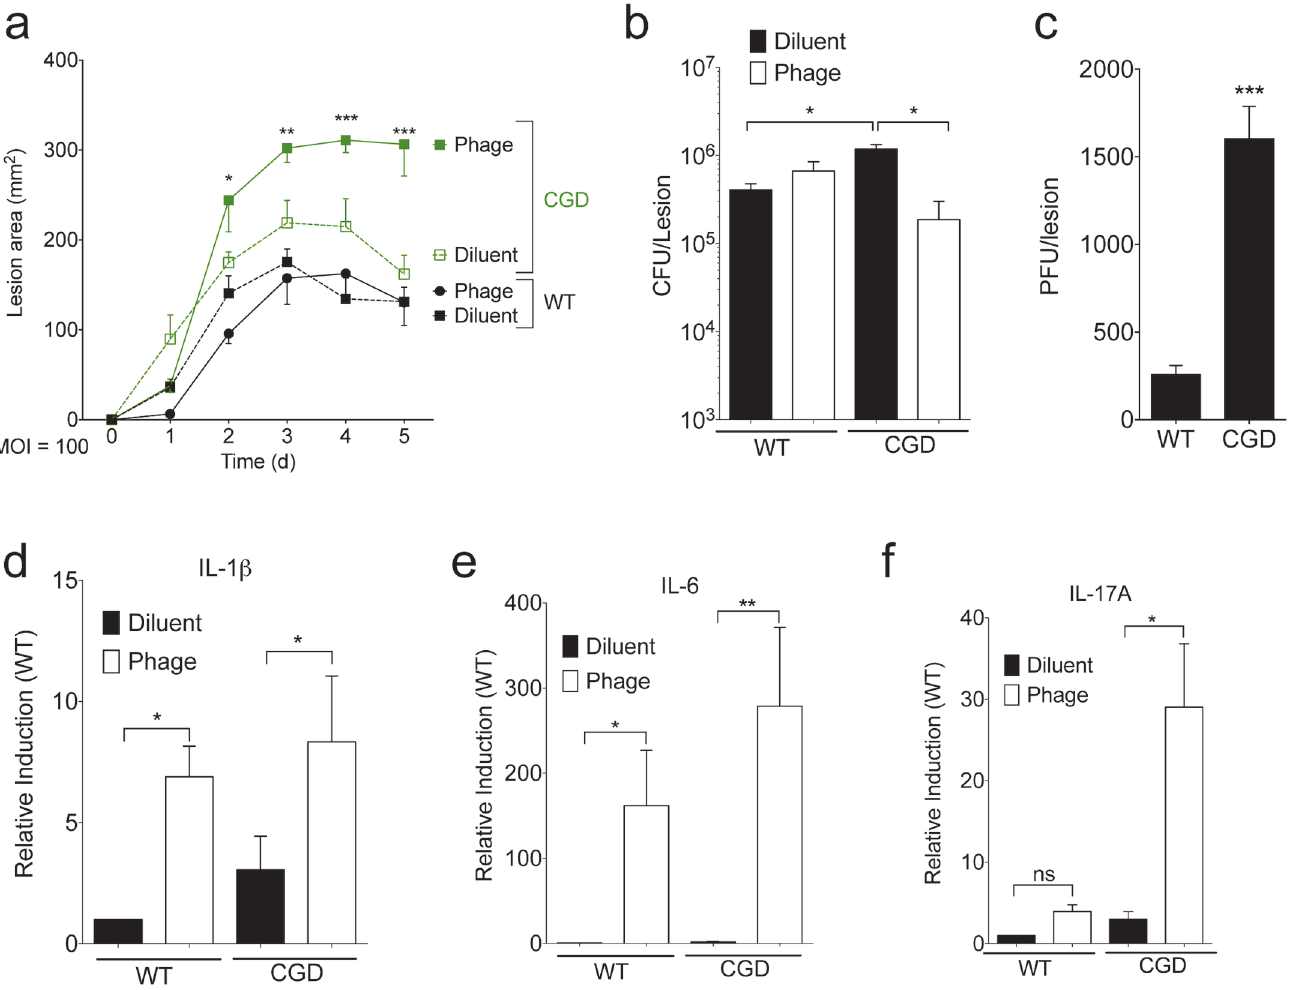
Fig 3. SATA-8505 Fails to Improve MRSA Skin Infection at High MOI. Lesion size (a), CFU (b), PFU (c), and transcript data (d-f) for mice injected with 10 9 plaque-forming units (PFU) of SATA-8505 immediately prior to subcutaneous injections of 10 7 CFU of USA300 processed in an identical manner as MOI of 1 experiments. Data shown are representative of 2 – 3 independent experiments using 5 or more mice per group, and displayed as mean + s.e.m. Differences were calculated by ANOVA with Bonferroni correction and depict differences from diluent treated wild type unless otherwise noted. ns = not significant, * = p < 0.05, ** = p < 0.01, *** = p < 0.001.